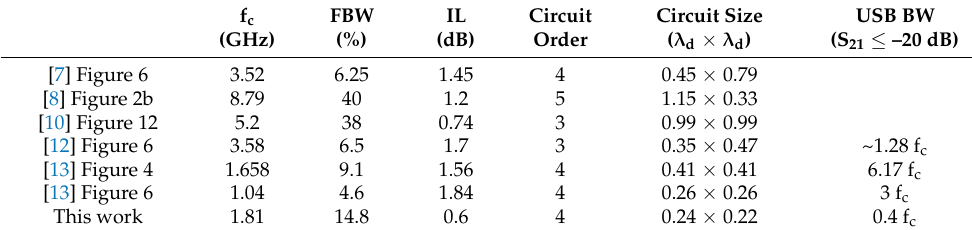
Table 1. The measured circuit performance comparison.